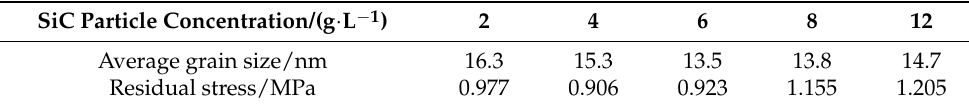
Table 5. Effect of SiC particle concentration on grain size and residual stress of coatings.